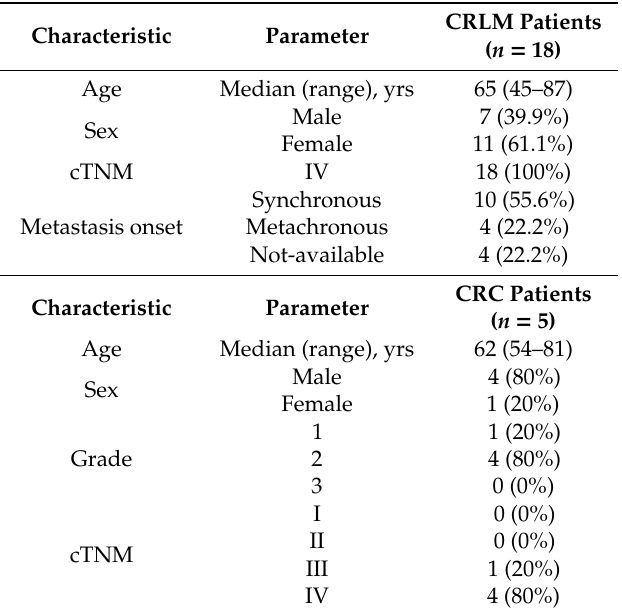
Table 1. Clinic-pathological characteristics of CRLM and CRC